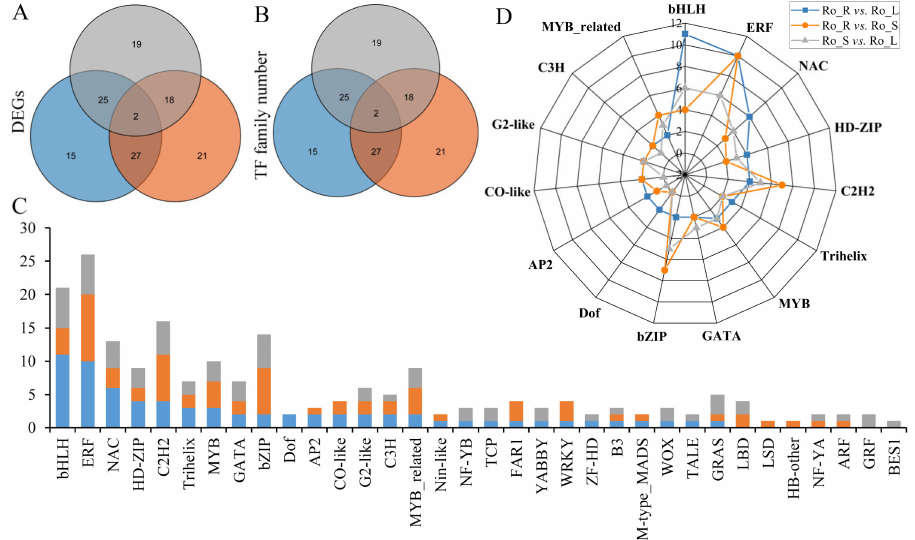
Figure 3. Differentially expressed TFs in the three comparison groups of R.officinale . Blue represents Ro_R vs. Ro_L, orange represents Ro_R vs. Ro_S, and gray represents Ro_S vs. Ro_L. ( A , B ) represent unigenes and family numbers of differentially expressed TFs in the three comparison groups, respectively. The three circles represent different comparison groups, and their overlaps indicate the number of common DEGs and TF families. ( C ) indicates the number of differentially expressed TFs. ( D ) presents the number of the top 15 differentially expressed TFs in the three comparison